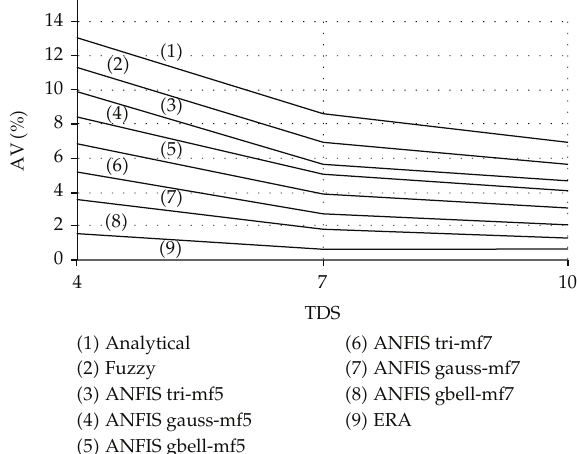
Figure 6: Average of absolute values of percentage errors of coe ffi cient analytical model, fuzzy model, SVD method, and six ANFIS methods for CRP9